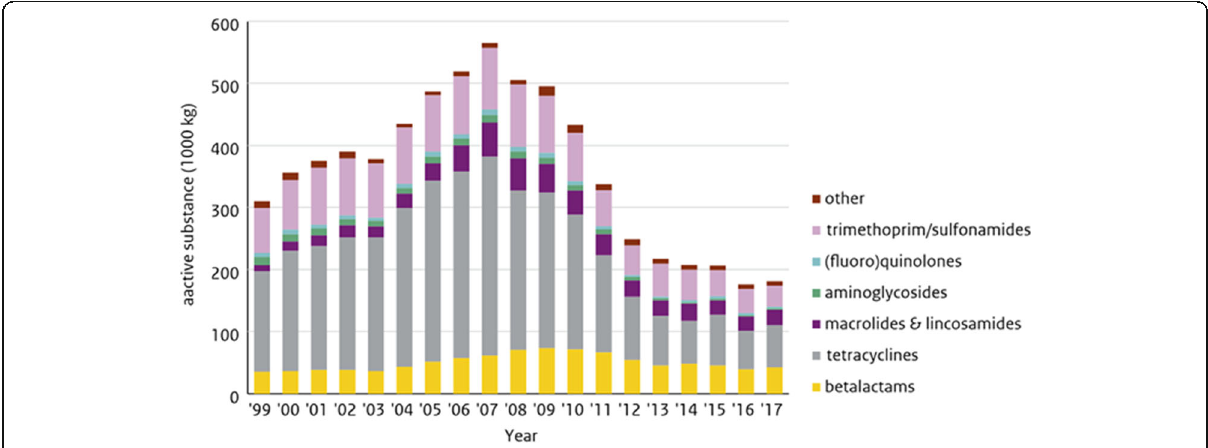
Fig. 12 The Netherlands Veterinary Medicines Institute (SDa): Developments in sales of antibiotics between 1999 and 2018, in number of kilograms of active substances sold (× 1,000) (source: FIDIN), by main pharmacotherapeutic